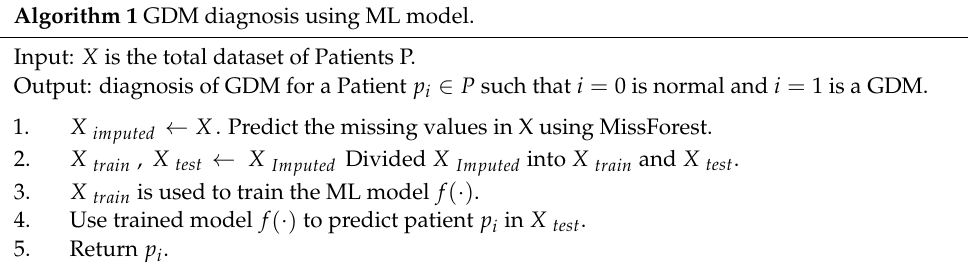
Algorithm 1 GDM diagnosis using ML